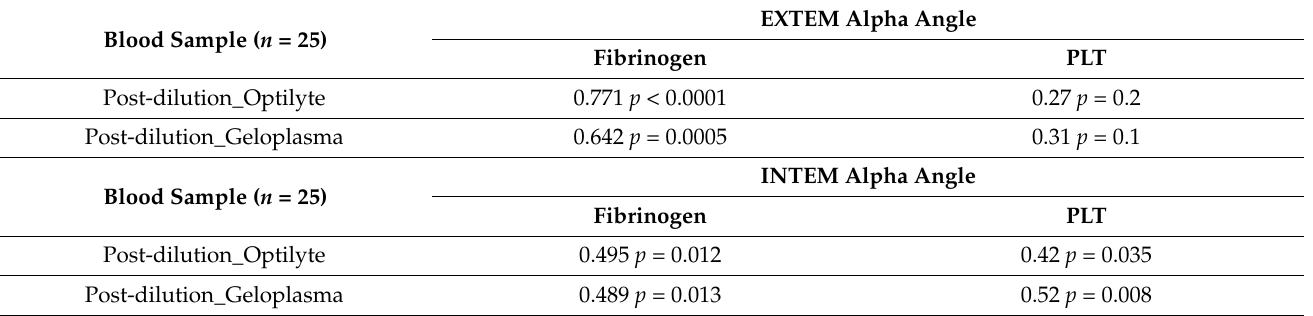
Table 2. Correlations between EXTEM and INTEM alpha angles and standard laboratory tests 1 .